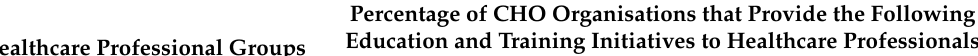
Table 2. Implementation of education and training initiatives in responding